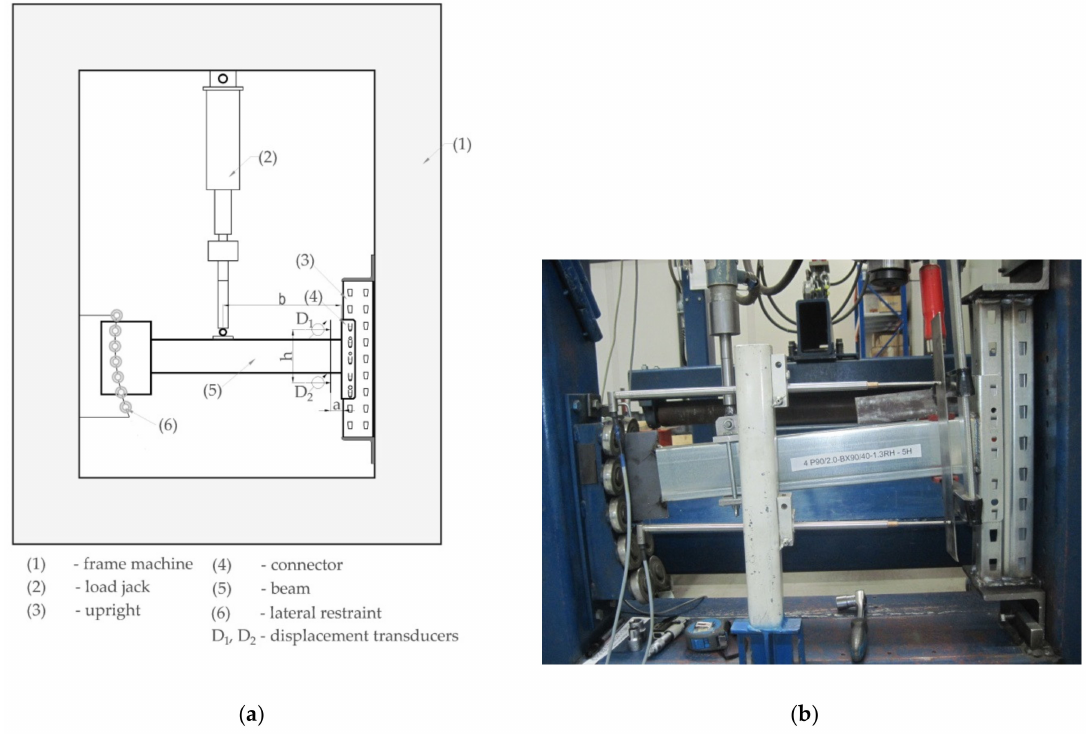
Figure 6. Bending test of the connection according to EN 15512 [9]: ( a ) scheme of the test stand and ( b ) photo of the experimental